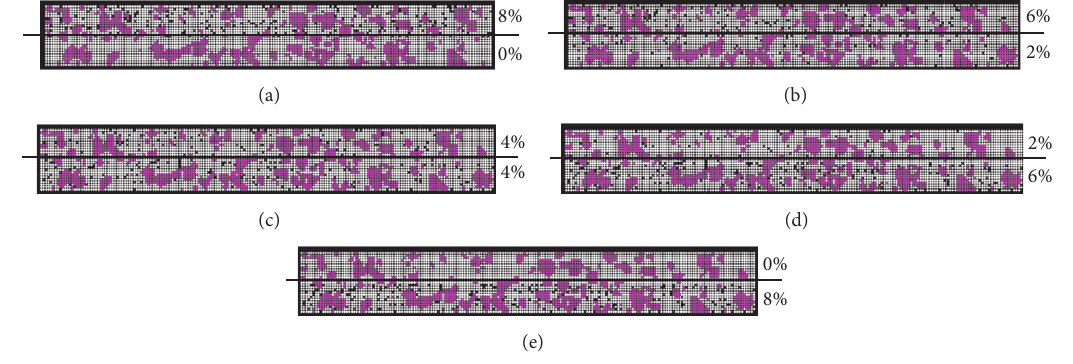
lower part (V8/0), 6% in the upper part and 2% in the lower part (V6/2), 4% in the upper part and 4% in the lower part (V4/4), 2% in the upper part and 6% in the lower part (V2/6), and 0% in the upper part and 8% in the lower part (V0/8), were generated. In Figure 10, along the horizontal direction, the samples were cut apart into three parts with the same volume. Six different air void content distributions, which are 0% in the side parts and 12% in the middle parts (H0/12/0), 1% in the side parts and 0% in the middle part (H1/10/1), 2% in the side parts and 8% in the middle part (H2/8/2), 4% in